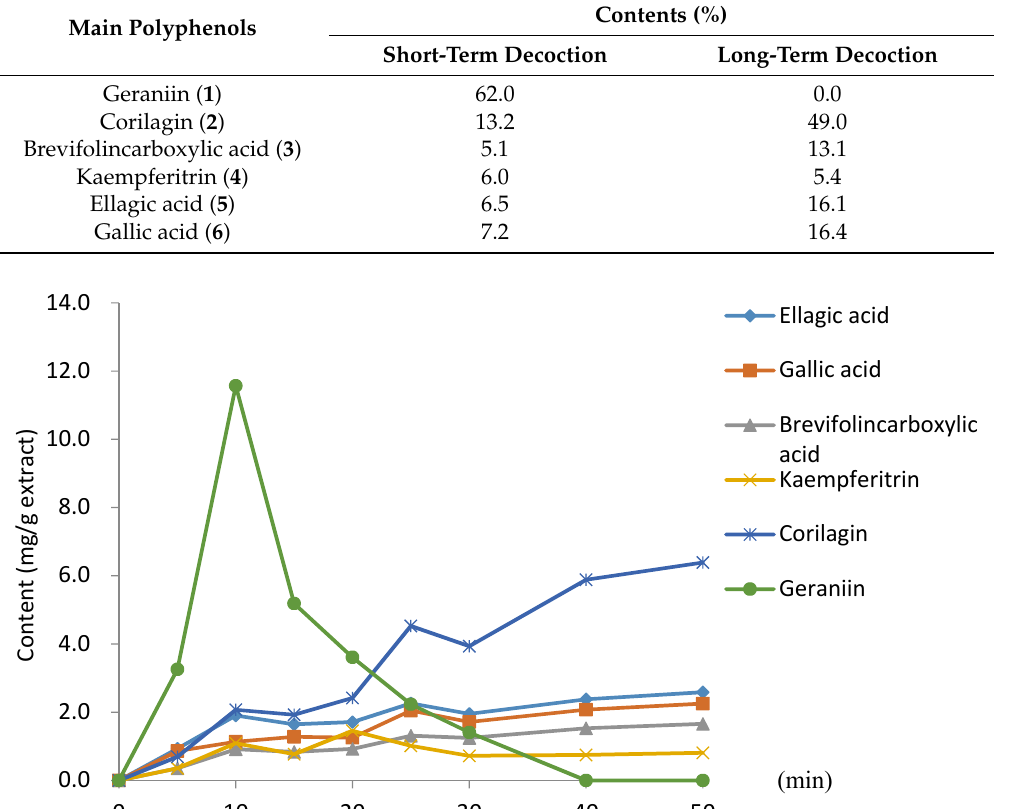
Table 2. % composition relative to the amount of total polyphenols in the short-term and long-term decoction extracts of G. thunbergii .